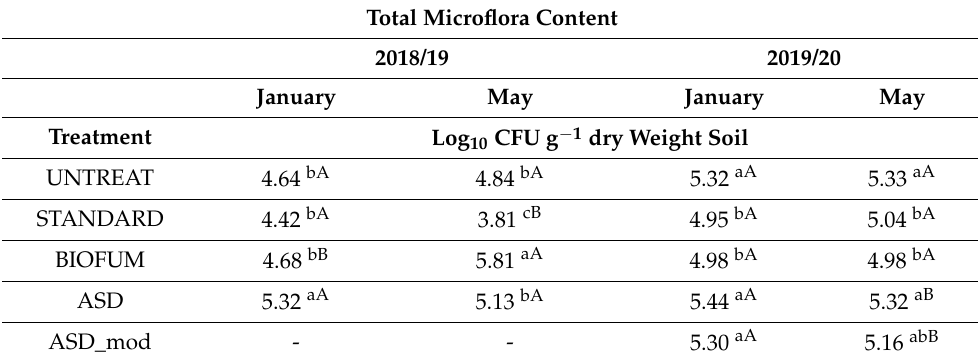
Table 3. Effect of the different soil pre-planting treatments on total microflora content in the 2018/19 and 2019/20 cropping